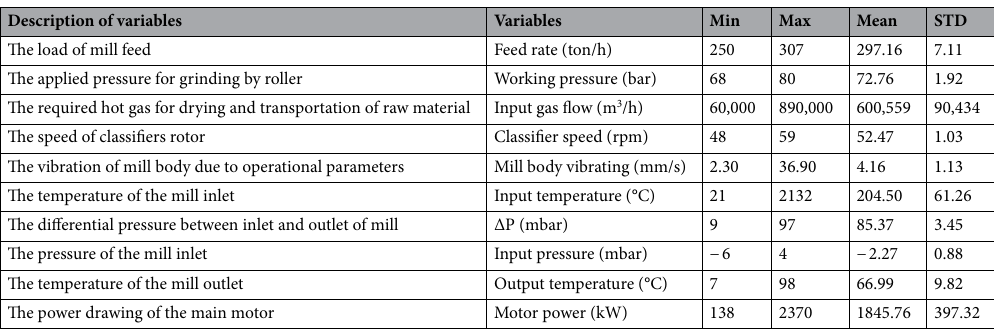
Table 1. Monitoring variables in the Ilam cement plant (STD: Standard